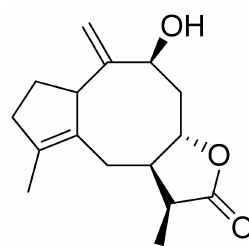
Figure 19. Antifeedant lactone from the fruits of Carpesium abrotanoides